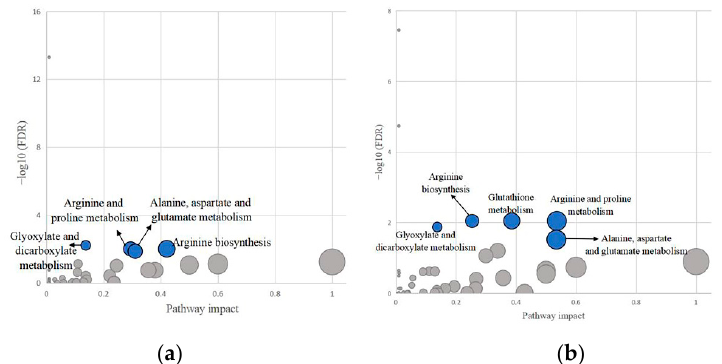
Figure 3. Overview of pathway analysis of human ( a ) neonatal and ( b ) maternal studies. The x-axis is the pathway impact value calculated based on topology analysis, while the y-axis indicates the significance level in enrichment analysis. Each circle in the figure represents a metabolic pathway. The circle size reflects the pathway impact value. And the blue circle indicates the pathway is significantly enriched (FDR < 0.05) and has relatively high impact value.